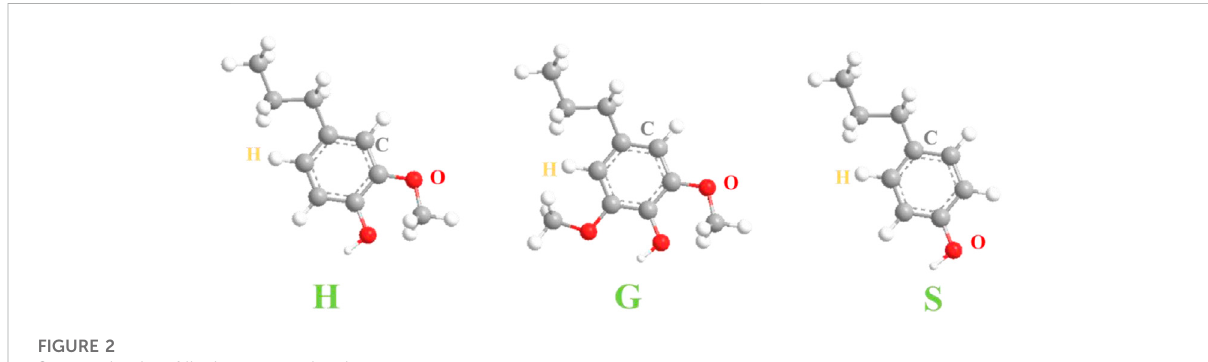
FIGURE 2 Structural units of lignin macromolecules.